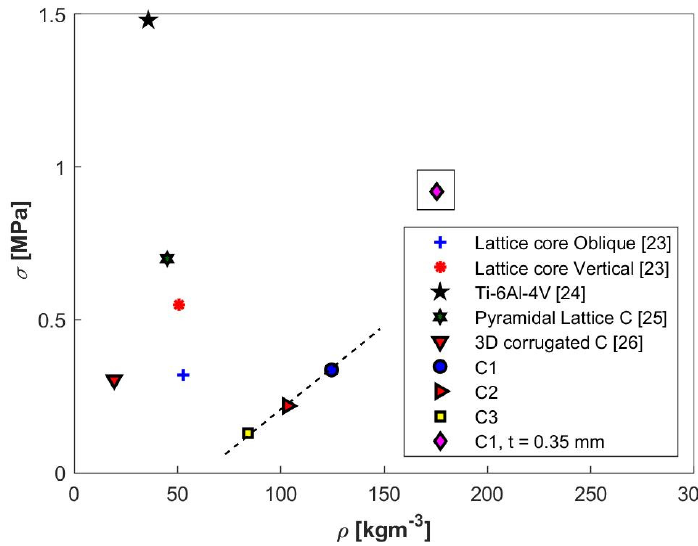
Figure 12. S trength as function of core density for several types of cellular structures. Figure 12. Strength as function of core density for several types of cellular